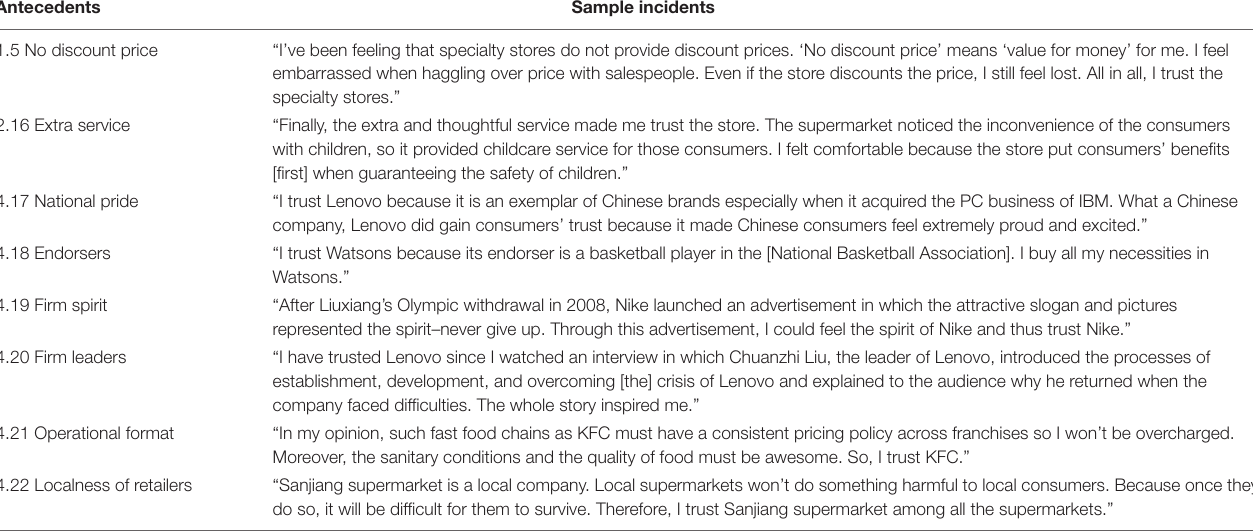
TABLE 2 | New antecedents of trust and sample incidents. Antecedents Sample